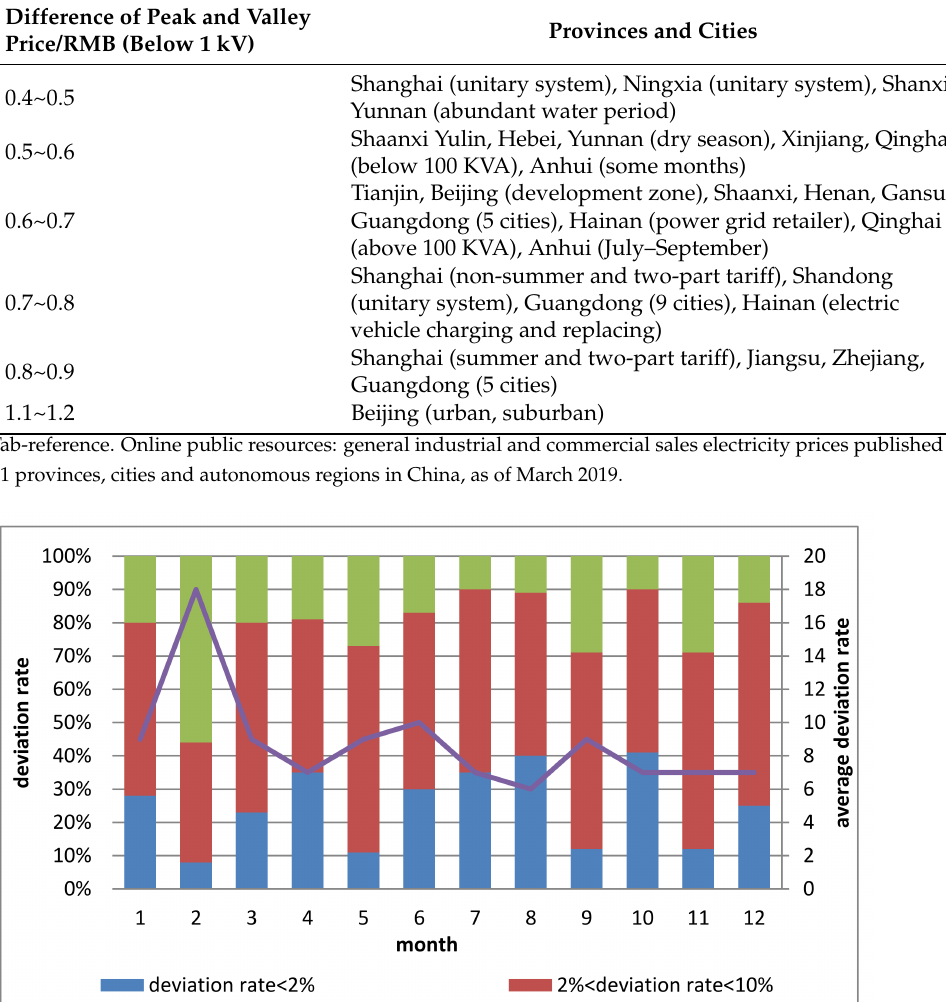
Figure 1. Schematic diagram of demand-side operations with ESD under peak-valley electricity prices. Table 2. Difference of peak-and-valley electricity prices in China.